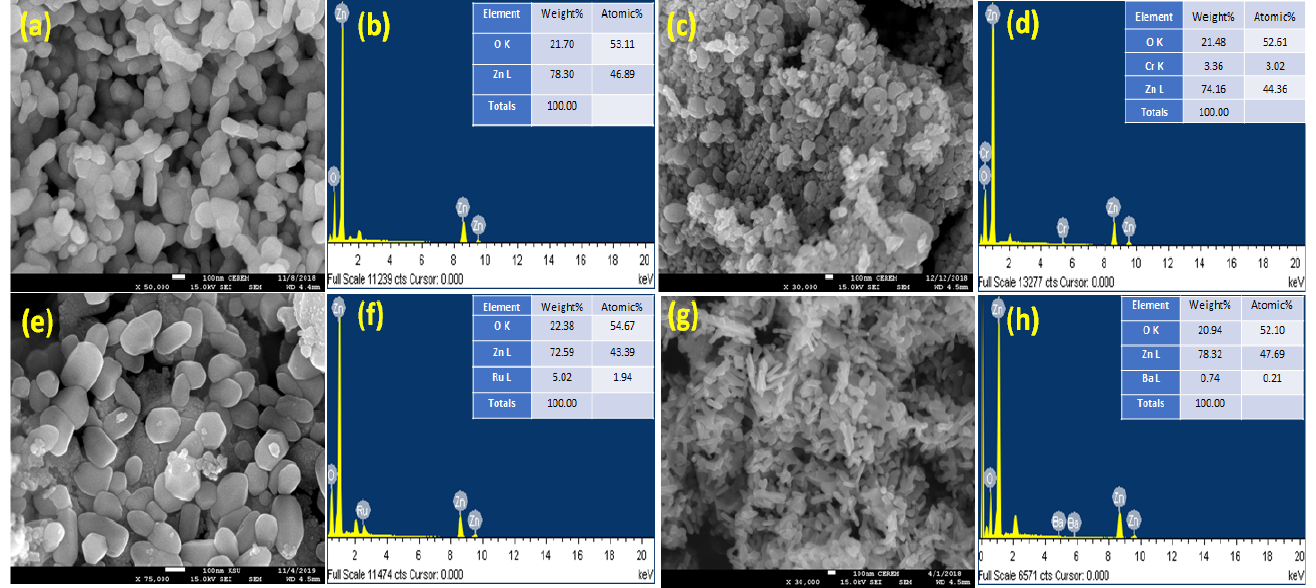
Figure 2. Morphology and chemical composition of ZnO, CrZnO, BaZnO, and RuZnO nanoparticles. ( a , b ): ZnO, ( c , d ): CrZnO, ( e , f ): RuZnO, ( g , h ): CrZnO